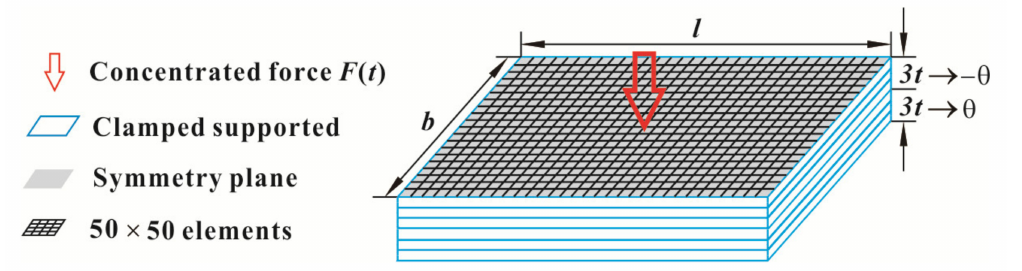
Figure 6. The composite laminated plate for numerical